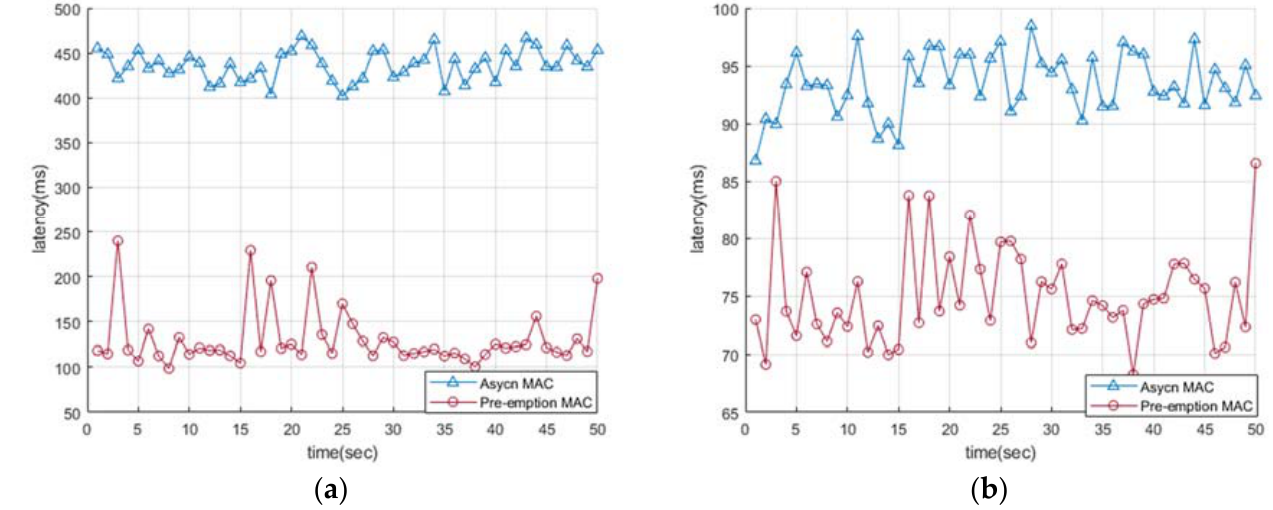
Figure 9. Comparison of latency Async MAC and Pre-emption MAC ( a ) Delay time of duty-cycle ratio (5%); ( b ) Delay time of duty-cycle ratio (25%).